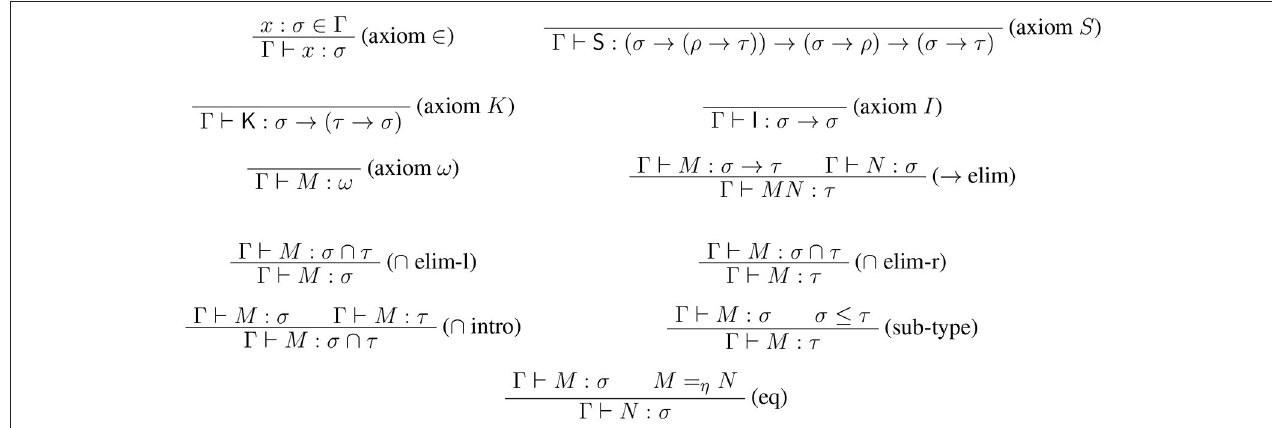
FIGURE 2 | Type-assignment system CL ∩